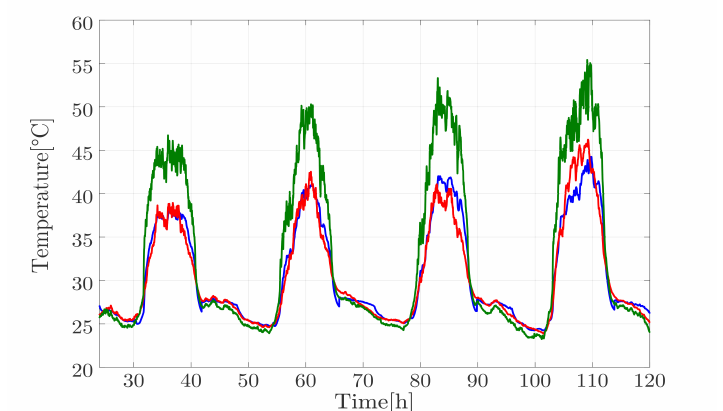
Figure 6. Environmental temperature (green line), internal temperature simulated(blue line), and experimental (red